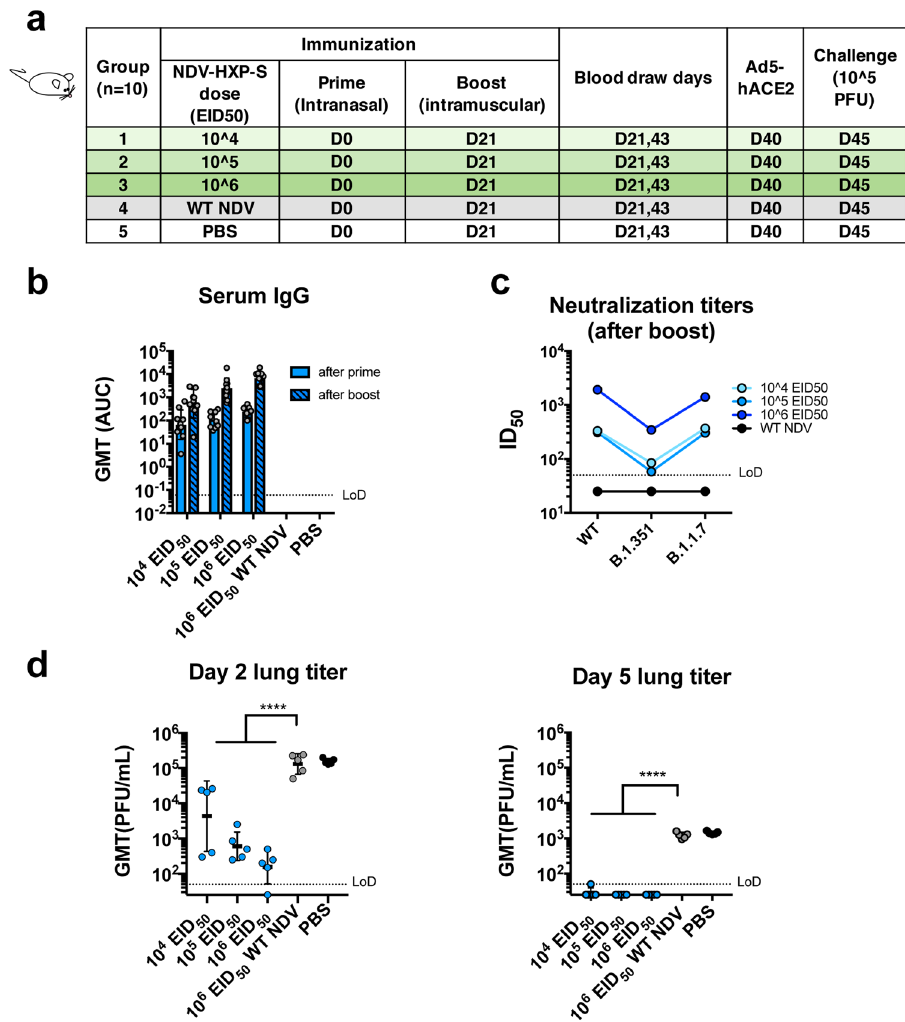
Fig. 6 Intranasal prime followed by an intramuscular boost of live NDV-HXP-S induces protective antibody responses in mice. a Design of the study. Seven-to-nine-week-old female BALB/c mice were used. Group 1 – 3 ( n = 10) were vaccinated with 10 4 , 10 5 , and 10 6 EID 50 of live NDV-HXP-S, respectively. Group 4 ( n = 10) was vaccinated with 10 6 EID 50 of WT NDV. Group 5 ( n = 10) was mock-vaccinated with PBS. The vaccine was administered via the intranasal (I.N.) route at D0 and intramuscular (I.M.) route at D21. Blood was collected at D21 and D43. Mice were sensitized with Ad5-hACE2 at D40 and challenged with 10 5 PFU of the USA-WA1/2020 strain at D45. b Spike-speci fi c serum IgG. Antibodies in post-prime (D21, solid blue bars) and post-boost (D43, pattern blue bars) sera were measured by ELISAs. GMT AUC was graphed. The error bars represent geometric SD. c Neutralizing activity of serum antibodies. Post-boost sera from groups 1 – 4 were pooled within each group and tested in neutralization assay against USA-WA/2020 strain (WT), B.1.351 variant, and B 1.1.7 variant in technical duplicate (cyan: 10 4 EID 50 ; light blue: 10 5 EID 50 ; blue: 10 6 EID 50 ; black: WT NDV). Serum dilutions inhibiting 50% of the infection (ID 50 ) were plotted (LoD = 1:50; An ID 50 = 1:25 was assigned to negative samples). d Viral load in the lungs. Lungs of a subset of animals ( n = 5) from each group were collected at day 2 and day 5 post challenge (blue: NDV-HXP-S; gray: WT NDV; black: PBS). The whole lungs were homogenized in 1 mL PBS. Viral titers were measured by plaque assay on Vero E6 cells and plotted as GMT of PFU/mL (LoD = 50 PFU/mL; a titer of 25 PFU/mL was assigned to negative samples). The error bars represent geometric SD. Statistical difference was analyzed by ordinary one-way ANOVA corrected for Dunnett ’ s multiple comparisons test (**** p <